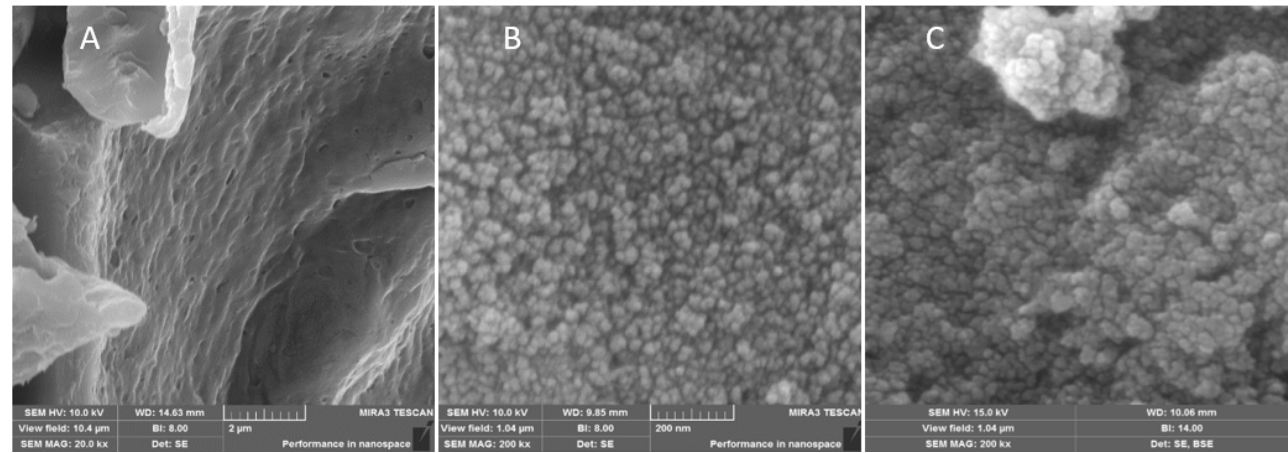
FIGURE 1 - Scanning electron microscopy for images a. E. angustifolia , b. Fe